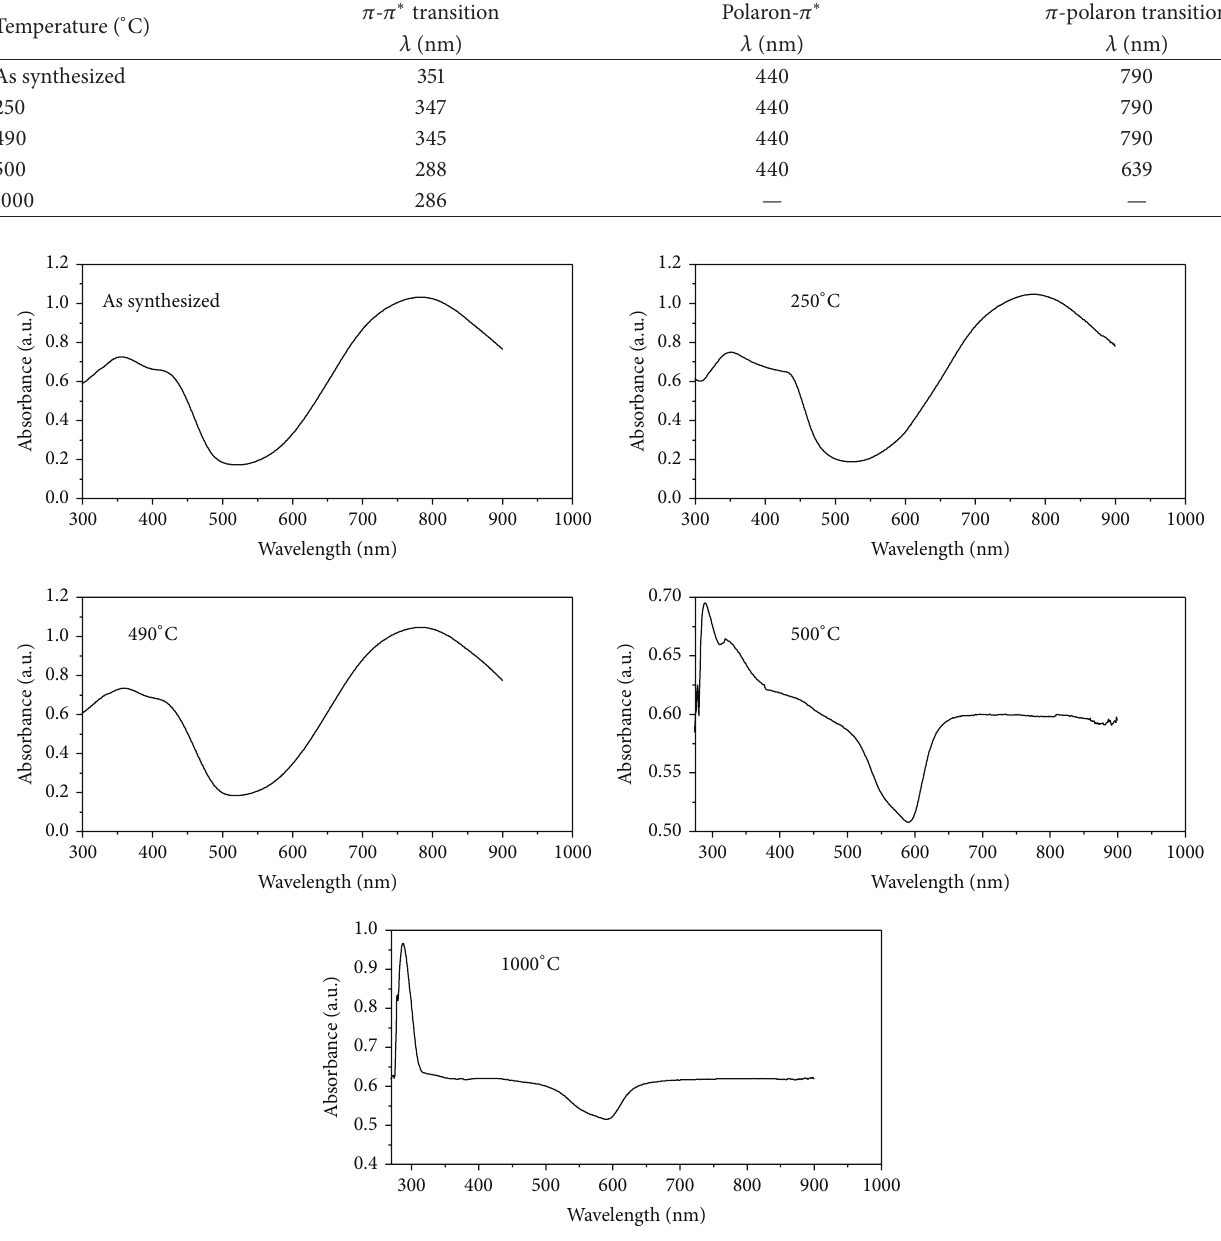
Figure 5: UV-Vis spectra of emeraldine salt samples recorded in tetrahydrofuran (THF) solvent. The sample is treated at various temperatures as